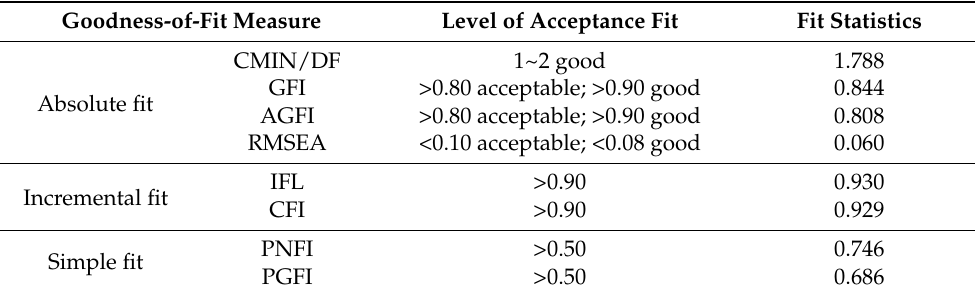
Table 3. Goodness-of-fit of the measurement model. Goodness-of-Fit Measure Level of Acceptance Fit Fit